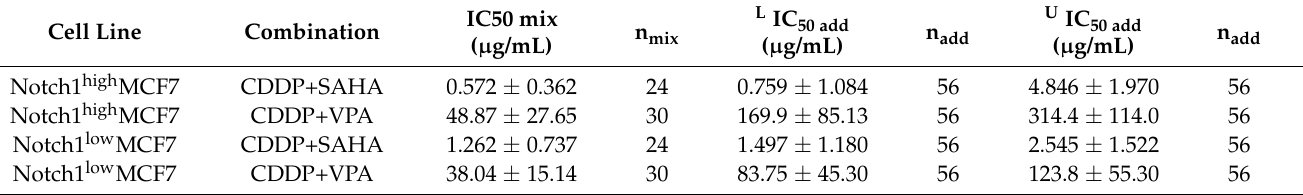
Table 2. Type I isobolographic analysis of interactions (for non-parallel DRRCs) between CDDP and SAHA or VPA at the fixed-ratio combination of 1:1 on MCF7 with increased or decreased activity of Notch1. Results are presented as median inhibitory concentrations (IC 50 values in µ g/mL ± S.E.M.) for two-drug mixtures, determined either experimentally (IC 50 mix) or theoretically calculated (IC 50 add) from the equations of additivity [26,27], blocking proliferation in 50% of tested cells in cancer cell lines (MCF7 with increased or decreased activity of Notch1). The n mix —total number of items used at those concentrations whose expected anti-proliferative effects ranged between 16% and 84% (i.e., 4 and 6 probits) for the experimental mixture; n add —total number of items calculated for the additive mixture of the drugs examined; L- IC50 add value calculated from the equation for the lower line of additivity; U- IC50 add value calculated from the equation for the upper line of additivity. Statistical evaluation of data was performed with unpaired Student’s t-test.